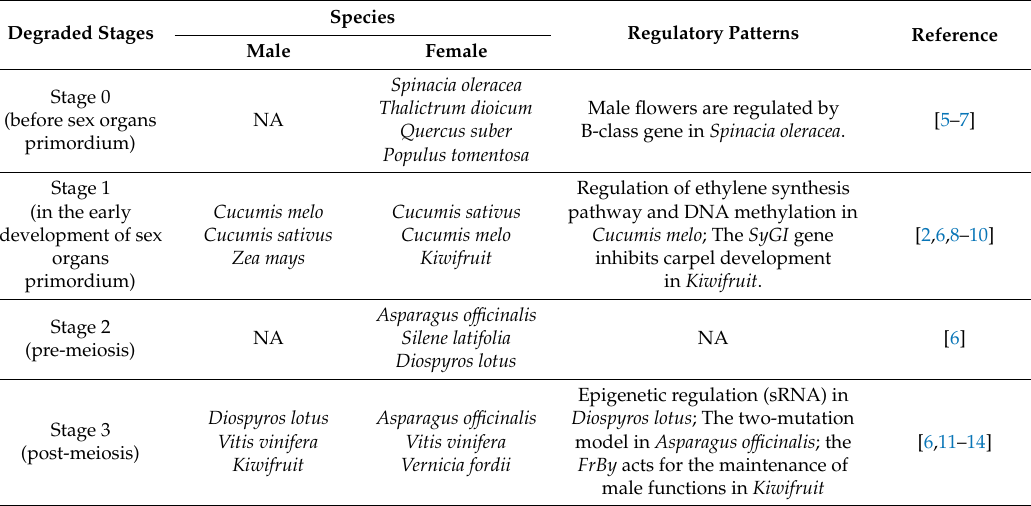
Table 1. Stages, species and regulatory patterns in unisexual flowers in